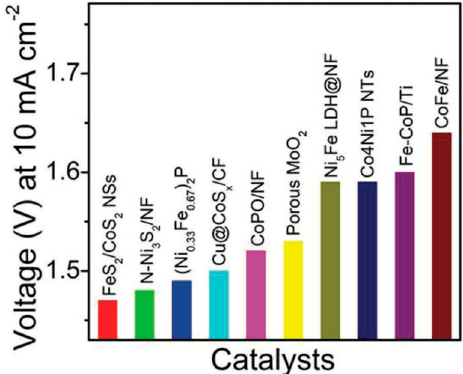
Figure 8. Comparison of the voltage for FeS 2 / CoS 2 interface nanosheets catalyst (red) with other reported non-noble metal overall water-splitting catalysts (at 10 mA cm − 2 ). Reprinted with permission from reference [82].